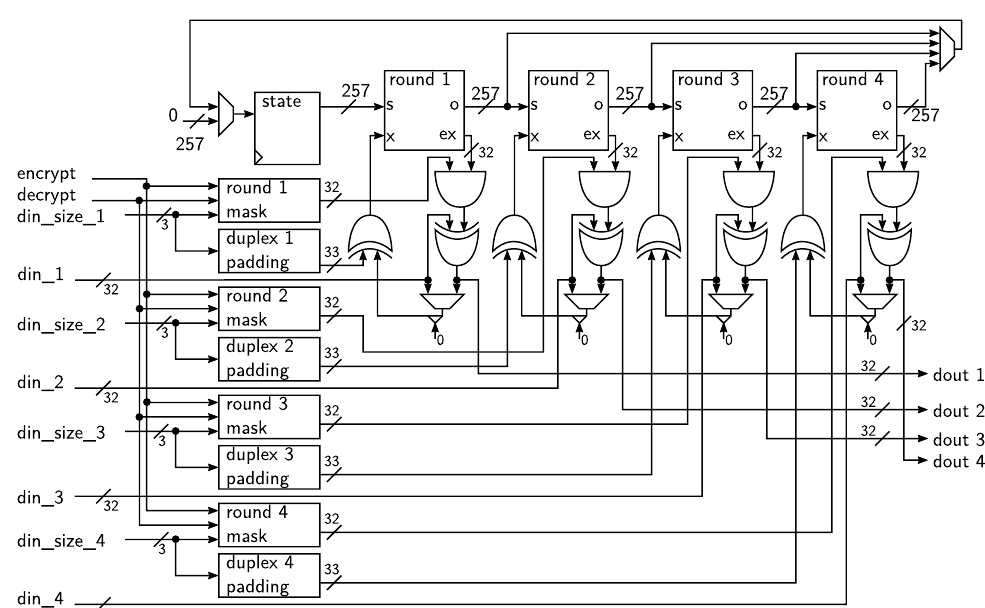
Figure 14: Subterranean 4-rounds duplex